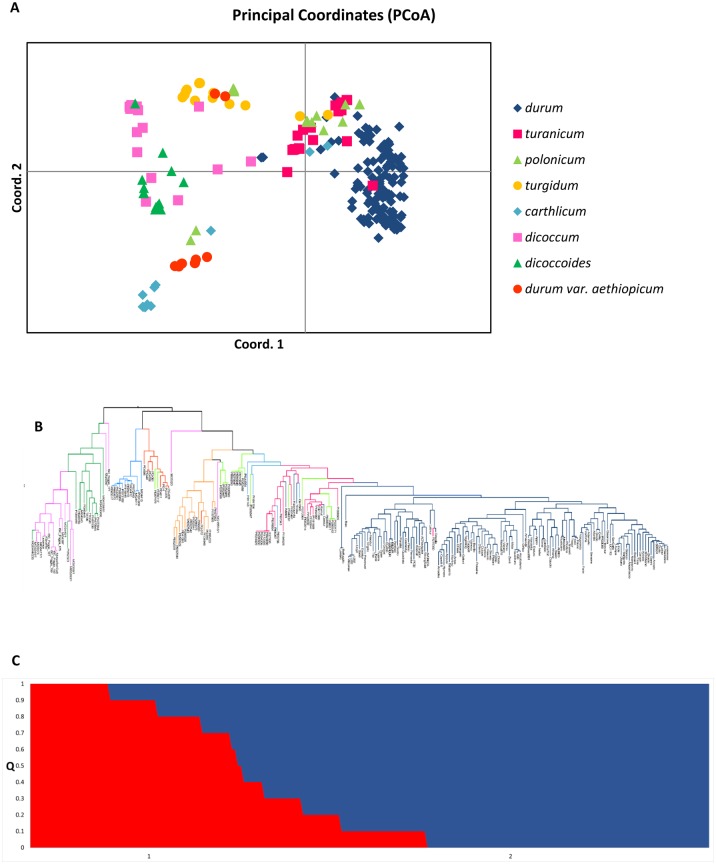
Genotypic data used to carry out a genome wide association study (GWAS).(A) Principal Coordinates Analysis (PCoA) plot of the first two components obtained from 90 K SNP iSelect for 230 tetraploid wheat accessions. (B) Unrooted bayesian tree of 90 K SNP iSelect using the bootstrap method with a replication of 1000 times. (C) STRUCTURE bar plot for K = 2 based on 90 K SNP iSelect genotyping data. Q value represents proportion of ancestry to a given subpopulation.